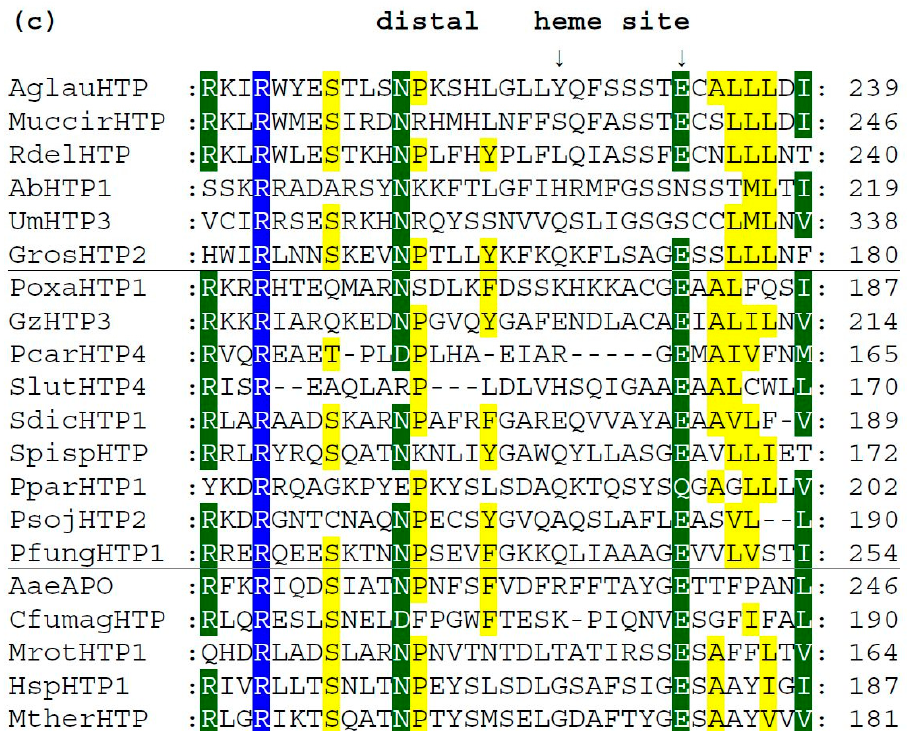
Figure 4. Multiple sequence alignment of 20 selected heme thiolate peroxidases. Only three highly conserved regions from the obtained muscle protein alignment [11] are shown here. Complete sequence alignment in FASTA format is provided in Figure S1. Regions shown: ( a ) sequence motif around the proximal ligand of heme; ( b ) motif with amino acid ligands responsible for the binding of a metal cation; ( c ) distal site of the prosthetic heme group. Abbreviations of all sequence names are explained in Table S1, together with their accession numbers in databases. Color scheme: blue > 95%, green > 75%, and yellow > 50% of overall conservation.